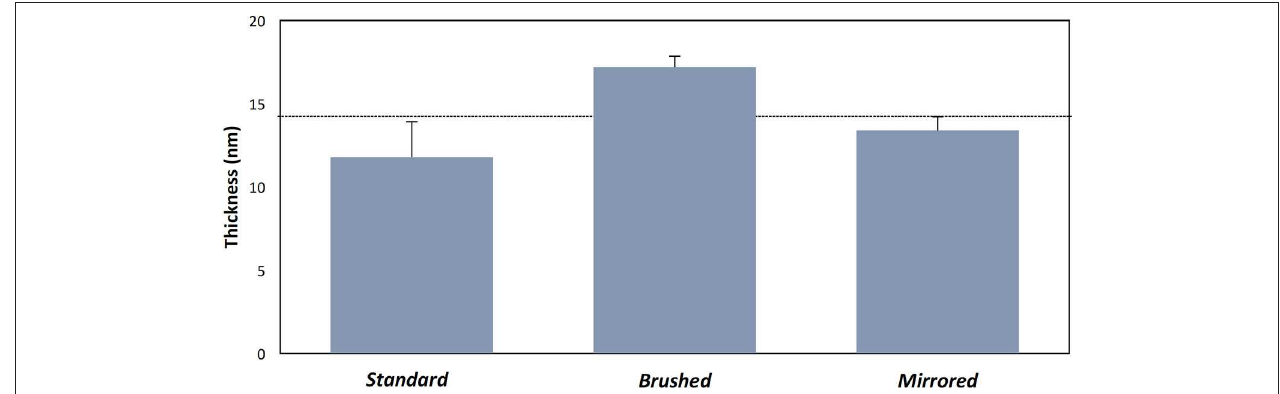
FIGURE 3 | Thickness measurements of pDA coatings with varying substrate roughness. Thickness measurements of the coating on various surface finishes from XPS measurements. The dotted line represents the mean thickness for all measurements. There were no significant differences found between samples.